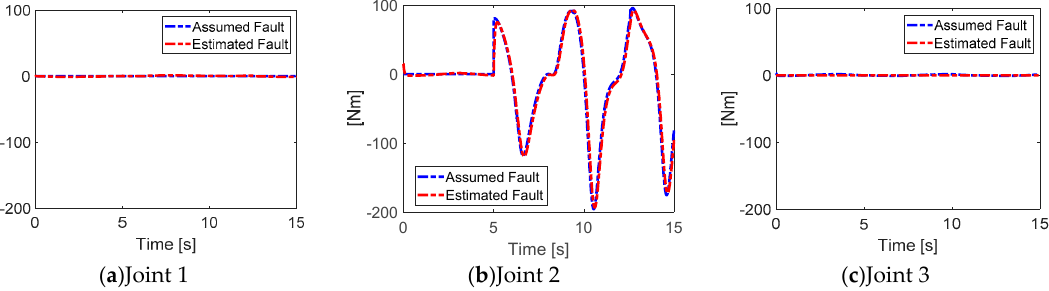
Figure 4. Fault estimation with a single fault at joint 2.